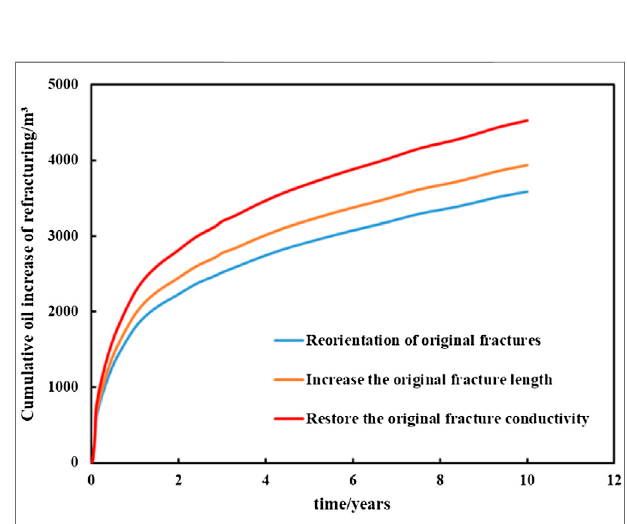
FIGURE 12 | Pressure distribution and remaining oil distribution before and after fracture turning. (A) Pressure distribution before fracture reorientation. (B) Pressure distribution after fracture reorientation. (C) Remaining oil distribution before fracture reorientation. (D) Remaining oil distribution after fracture reorientation.